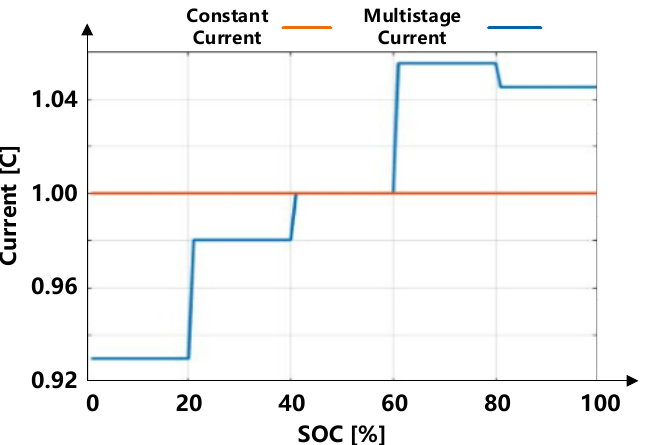
Table 2. Upper leg battery parameters of phase A.